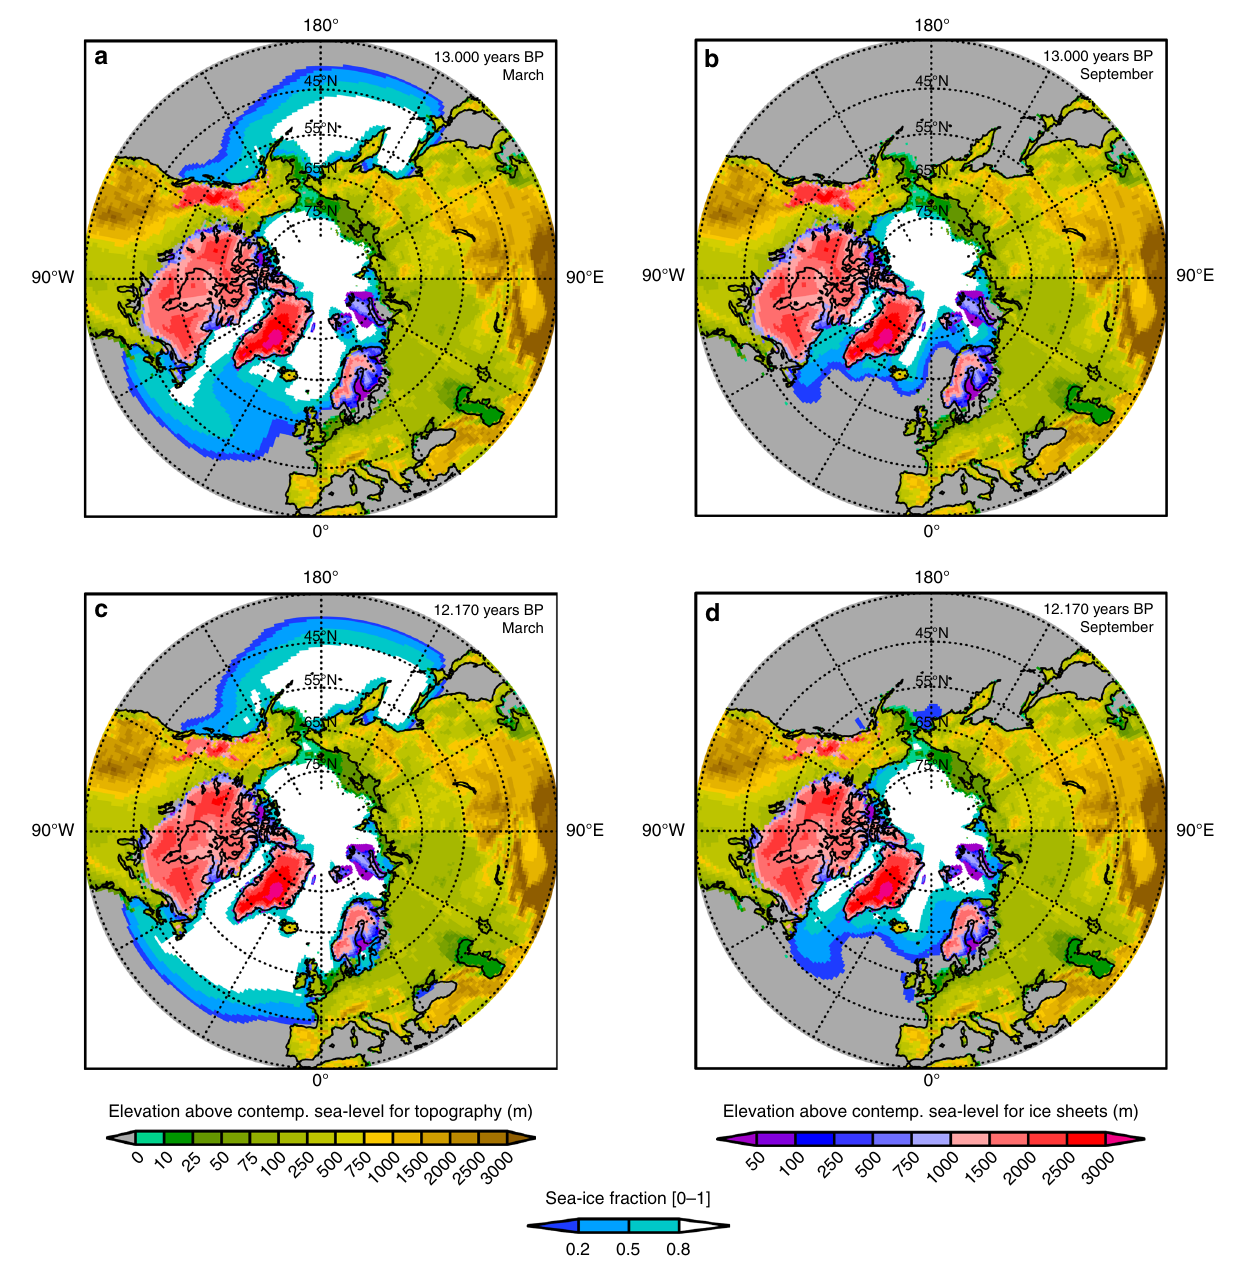
Fig. 1 Late-glacial topography, ice sheets and sea-ice extent for BA and YD. The sea-ice extent represents here the simulated winter maximum ( a , c , March) vs. summer minimum ( b , d , September) for the late BA interstadial ( a , b ) and mid-YD stadial ( c , d ). The simulated change in sea-ice extent corresponds to an AMOC reduction from BA to YD of around − 36% based on CCSM3 25,26 . The paleotopography is consistent with contemporary sea- level stands and updated ice sheet reconstructions of GLAC-1B ( 42 ,